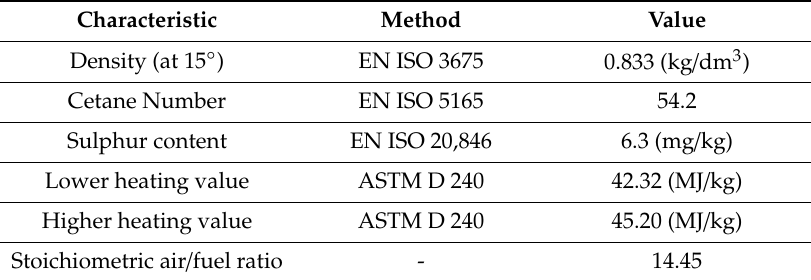
Table 4. Main characteristics of the B10 Diesel blend [36].